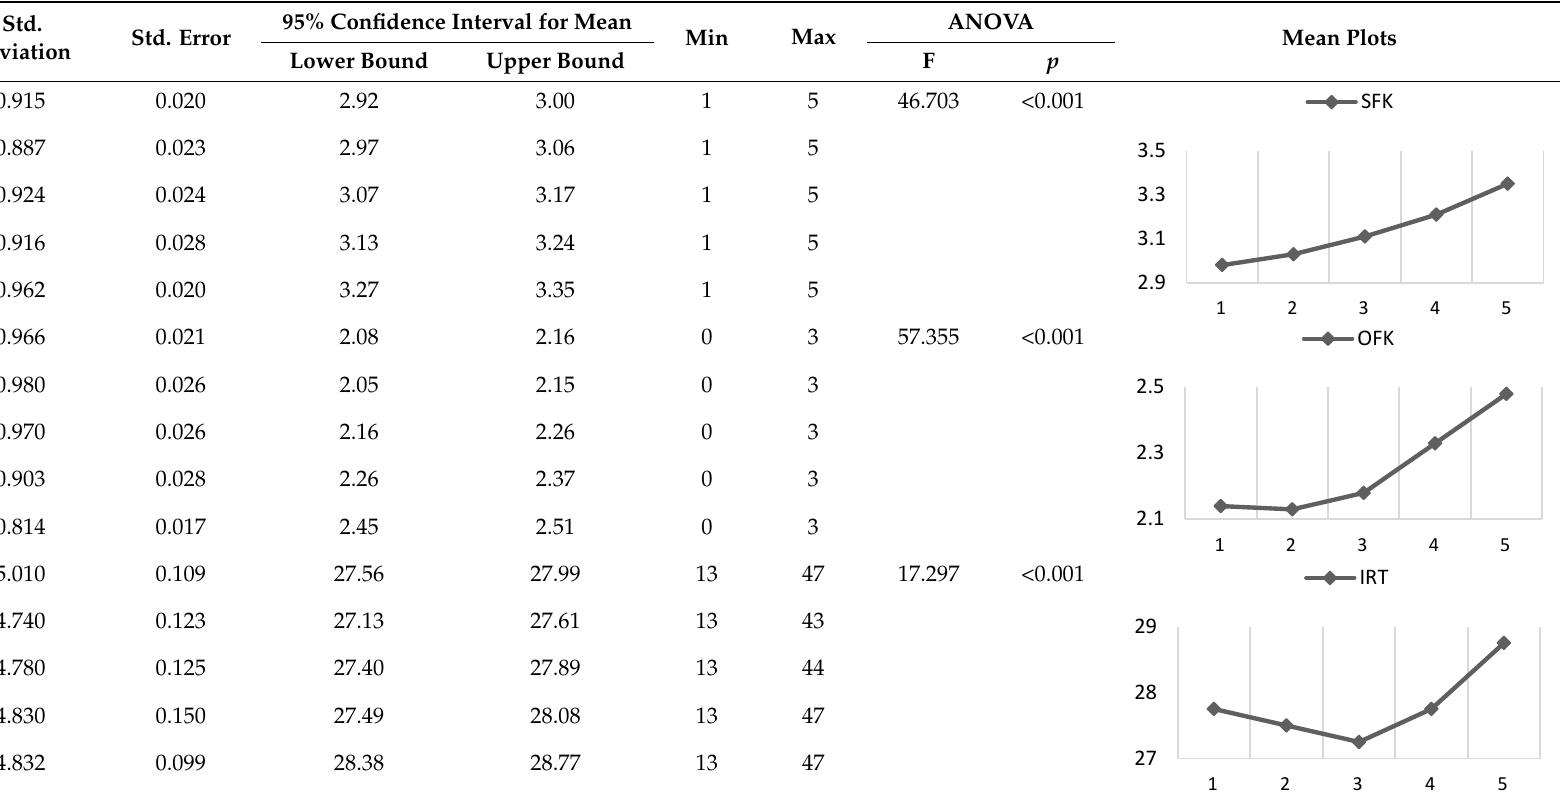
Table 6. Financial Knowledge and Investment Risk Tolerance Comparisons Across Income Categories (N = 8038).